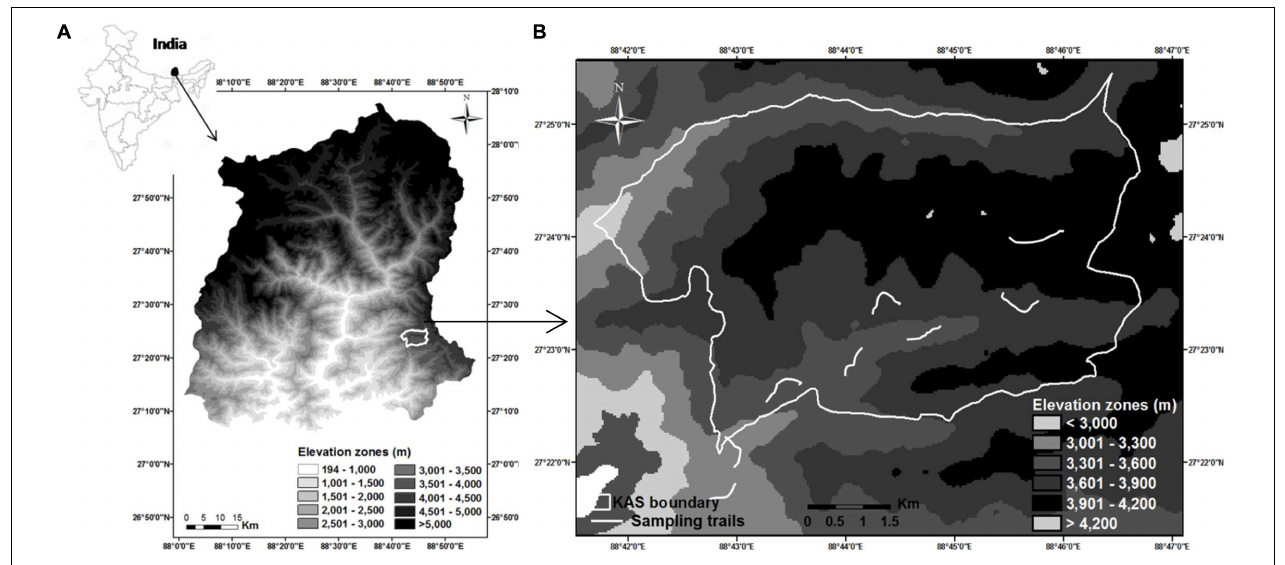
FIGURE 1 | Study area map showing (A) location of Kyongnosla Alpine Sanctuary in Sikkim (B) classification of elevation zones and location of sampling trails—Trails located in elevation zones below 3,600 m are for goral and those above 3,600 m are for musk deer. TABLE 1 | The number of fecal samples of musk deer and goral collected from different trails in different months starting from January to December coded as 1 to 12. Trail name Number of samples